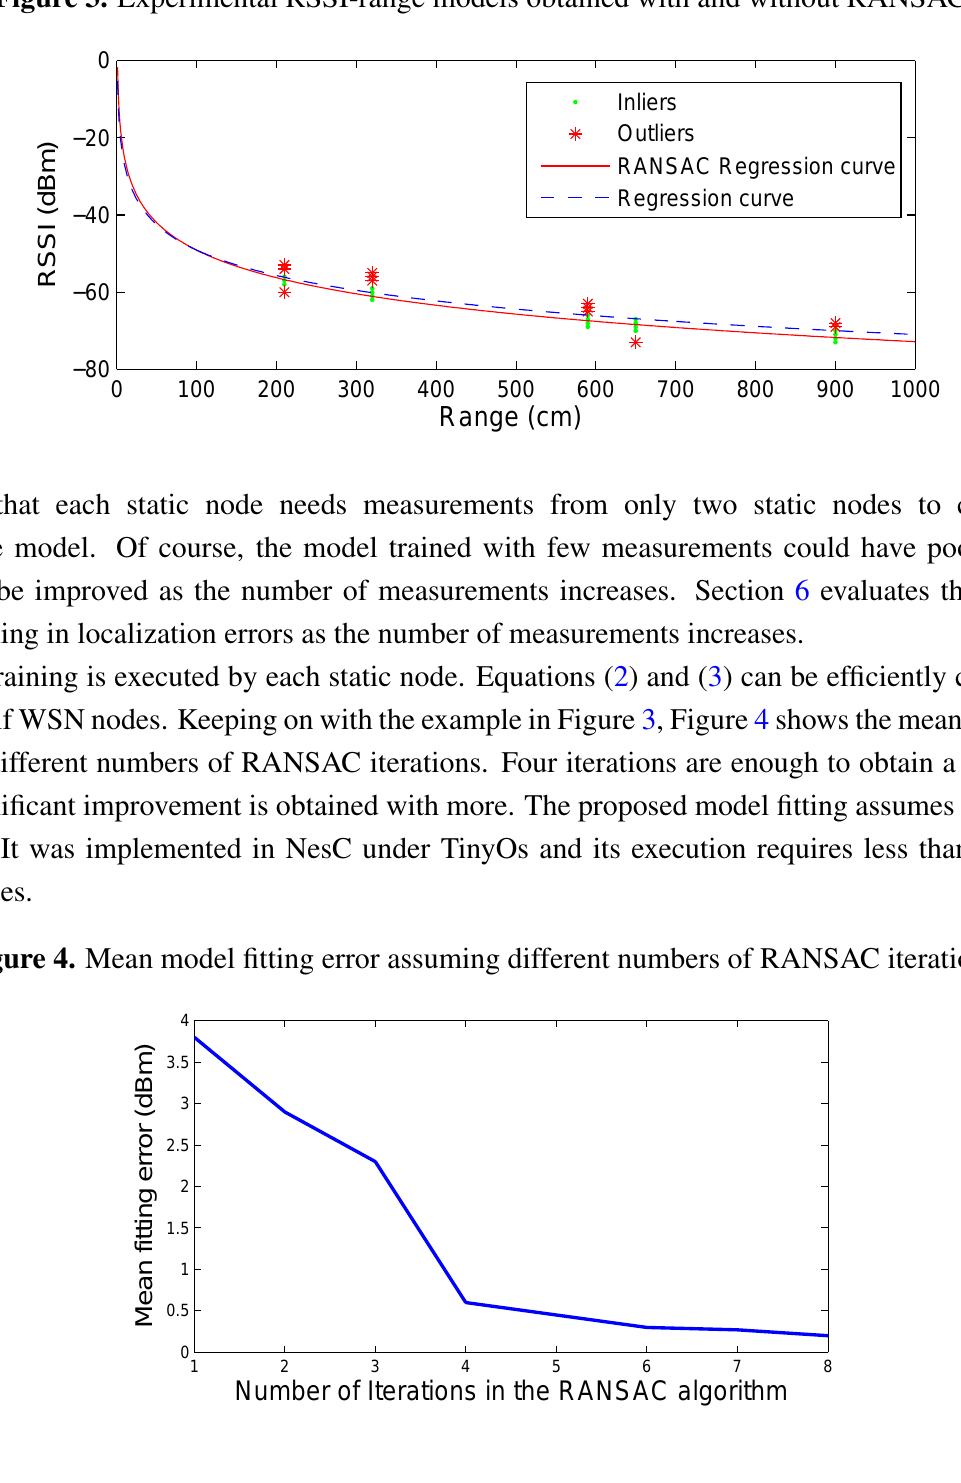
Figure 3. Experimental RSSI-range models obtained with and without RANSAC.